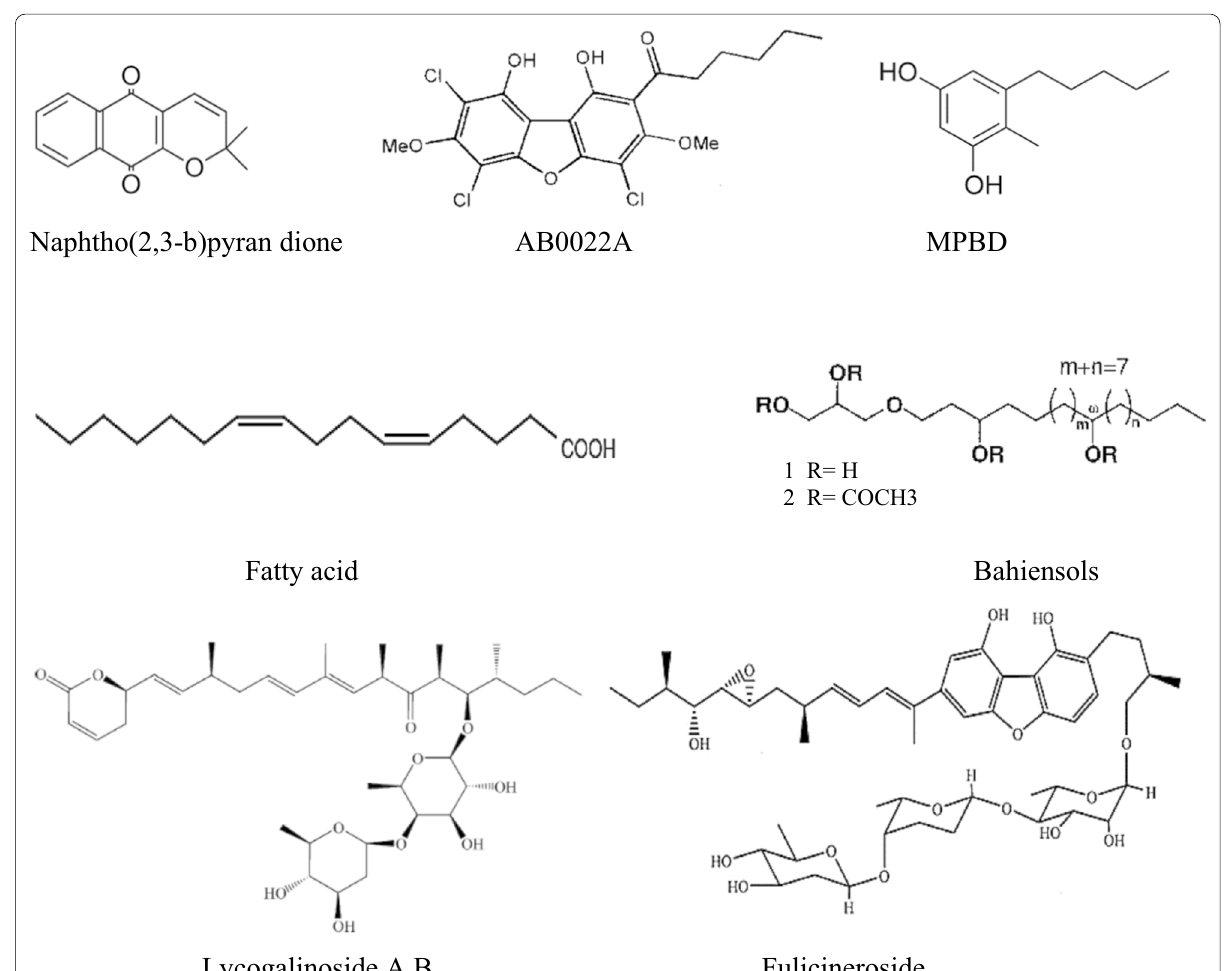
Fig. 12 Non-pigment components from slime molds with antimicrobial